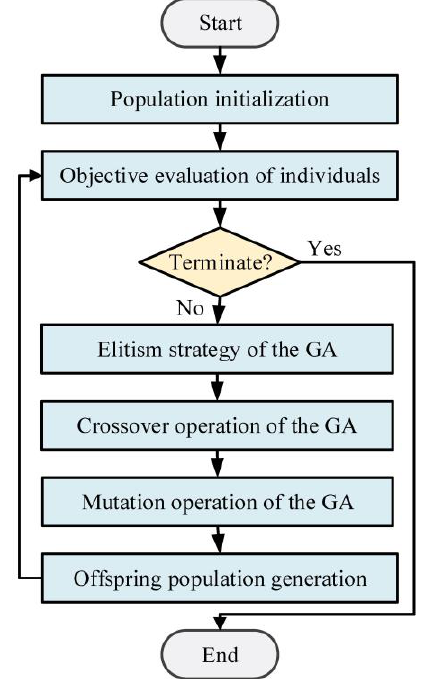
Figure 3. Flow chart of the genetic algorithm.